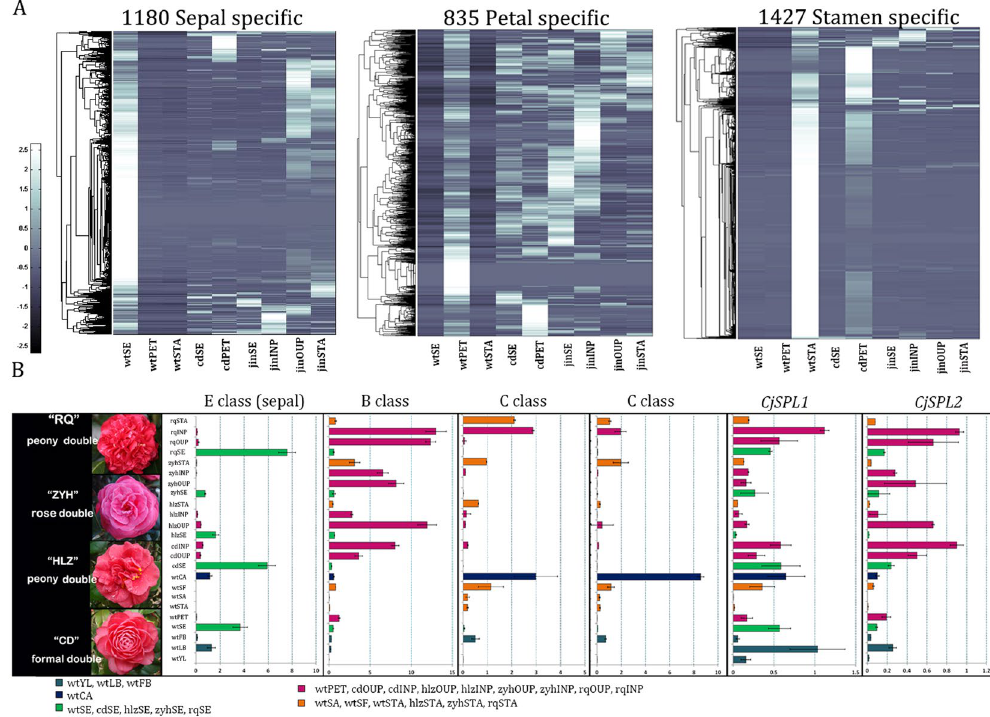
Figure 6. Whorl-specific genes and expression analysis of key regulators in various double flowers in Camellia . (A ) Whorl specific genes displayed disrupted expression patterns in doubled flower culvars. The genes with preference in one organ of wild Camellia sepal, petal and stamen were identified through expression analysis. The mean expression of samples was obtained and normalized by the z score method. Normalized expression of clusters was plotted in the heatmap figure. ( B ) Expression analysis of floral regulators in different double flower cultivars. “RQ”, Rongqiu, peony double; “ZYH”, ZhuangYuanHong, rose double; “HLZ”, HongLuZhen, peony double with modified arrangements of inner petal and stamen whorls; “CD”, ChiDan, formal double. Organ types were grouped by the positional homology and indicated in different colors. wtYL, wild type young leaf; wtLB, wild type leaf bud; wtFB, wild type floral bud; wtSE, wild type sepal; wtPET, wild type petal; wtSTA, wild type stamen; wtSA, wild type anther; wtSF, wild type filaments; wtCA, wild type carpel; cdSE, ChiDan sepal; cdOUP, ChiDan petals in outer whorls; cdINP, ChiDan petals in the inner whorls; hlzSE, HongLuZhen sepal; hlzOUP, HongLuZhen outer petal; hlzINP, HongLuZhen inner petal; hlzSTA, HongLuZhen stamen; zyhSE, ZhuangYuanHong sepal; zyhOUP, ZhuangYuanHong outer petal; zyhINP, ZhuangYuanHong inner petal; zyhSTA, ZhuangYuanHong stamen; rqSE, RongQiu sepal; rqOUP, RongQiu outer petal; rqINP, RongQiu inner petal; rqSTA, RongQiu